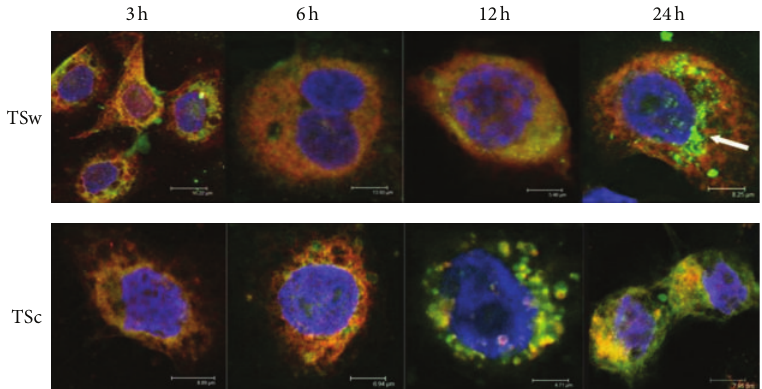
Figure 4: Laser-scanning confocal microscopy for internalization of green fluorescent FITC-TSw, respectively, FITC-TSc (50 𝜇 g/mL) in HaCaT after incubation of 3h, 6h, 12h, and 24h. Nuclei were labeled with blue fluorescent DAPI (1 𝜇 g/mL). Green spots: FITC-TSw, respectively, FITC-TSc; red spots: Dextran-TexasRed labeled endosomes; yellow spots: Colocalization of FITC-TSw, respectively, FITC-TSc and Dextran-TexasRed labeled endosomes structures. Arrows point to zones of not internalized FITC-labeled xyloglucans.